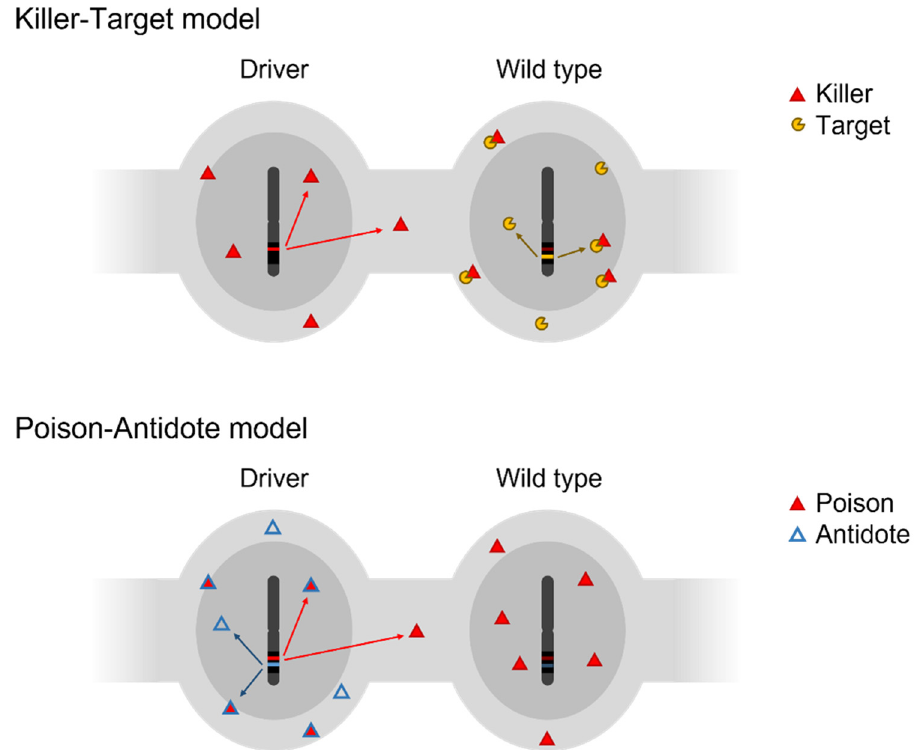
Figure 2. Killer–Target and Poison–Antidote models of transmission ratio distortion. The cells represented are round spermatids developing in a syncytium in a male heterozygous for the drive locus (black region on the chromosome). The killer/poison factors, produced solely by the « driver » chromosome, are shared across cytoplasmic bridges. The target and antidote factors are produced by the wild type and driver chromosomes, respectively, and are not shared across bridges.